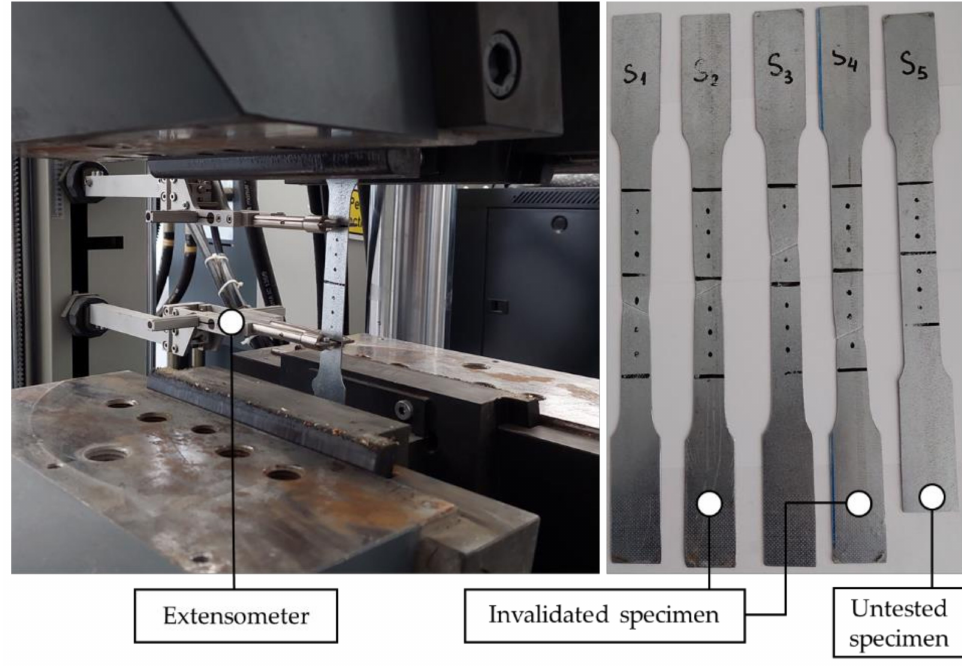
Figure 11. Specimens mounted with extensometer during the tests and specimens